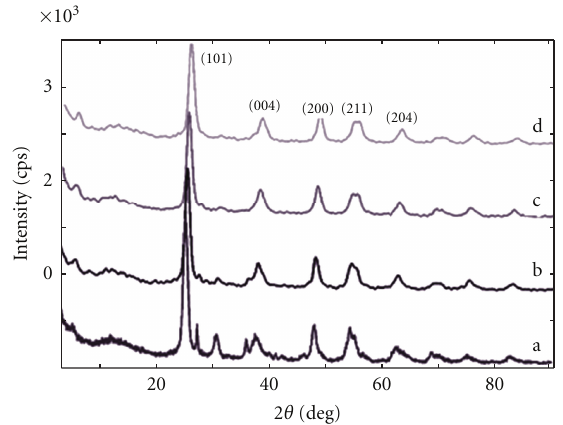
Figure 1: XRD patterns of (a) undoped TiO 2 , (b) 0.75 wt.% of Mg 2+ -doped TiO 2 , (c) 1.0 wt.% of Mg 2+ -doped TiO 2 , and (d) 1.25 wt.% of Mg 2+ -doped TiO 2